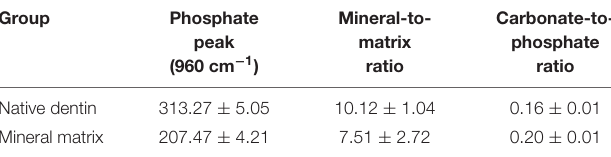
TABLE 2 | Normalized spectra intensity of mineral